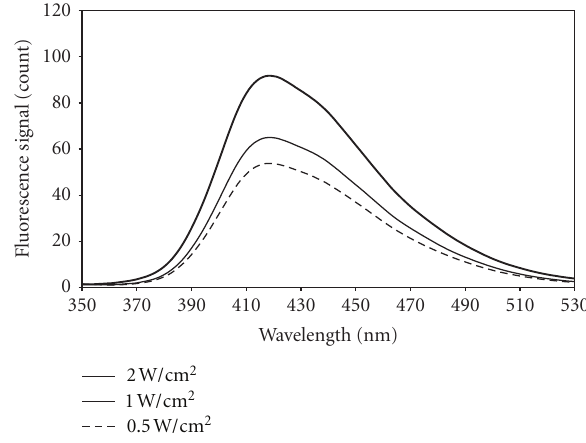
Figure 1: Recorded fluorescence emission spectrum from the TA solution without GNPs in the field of 1MHz ultrasound waves at intensities of 0.5, 1, and 2 W/cm 2 in continuous mode, excitation wavelength = 310 nm, and emission and excitation band width = 5nm.